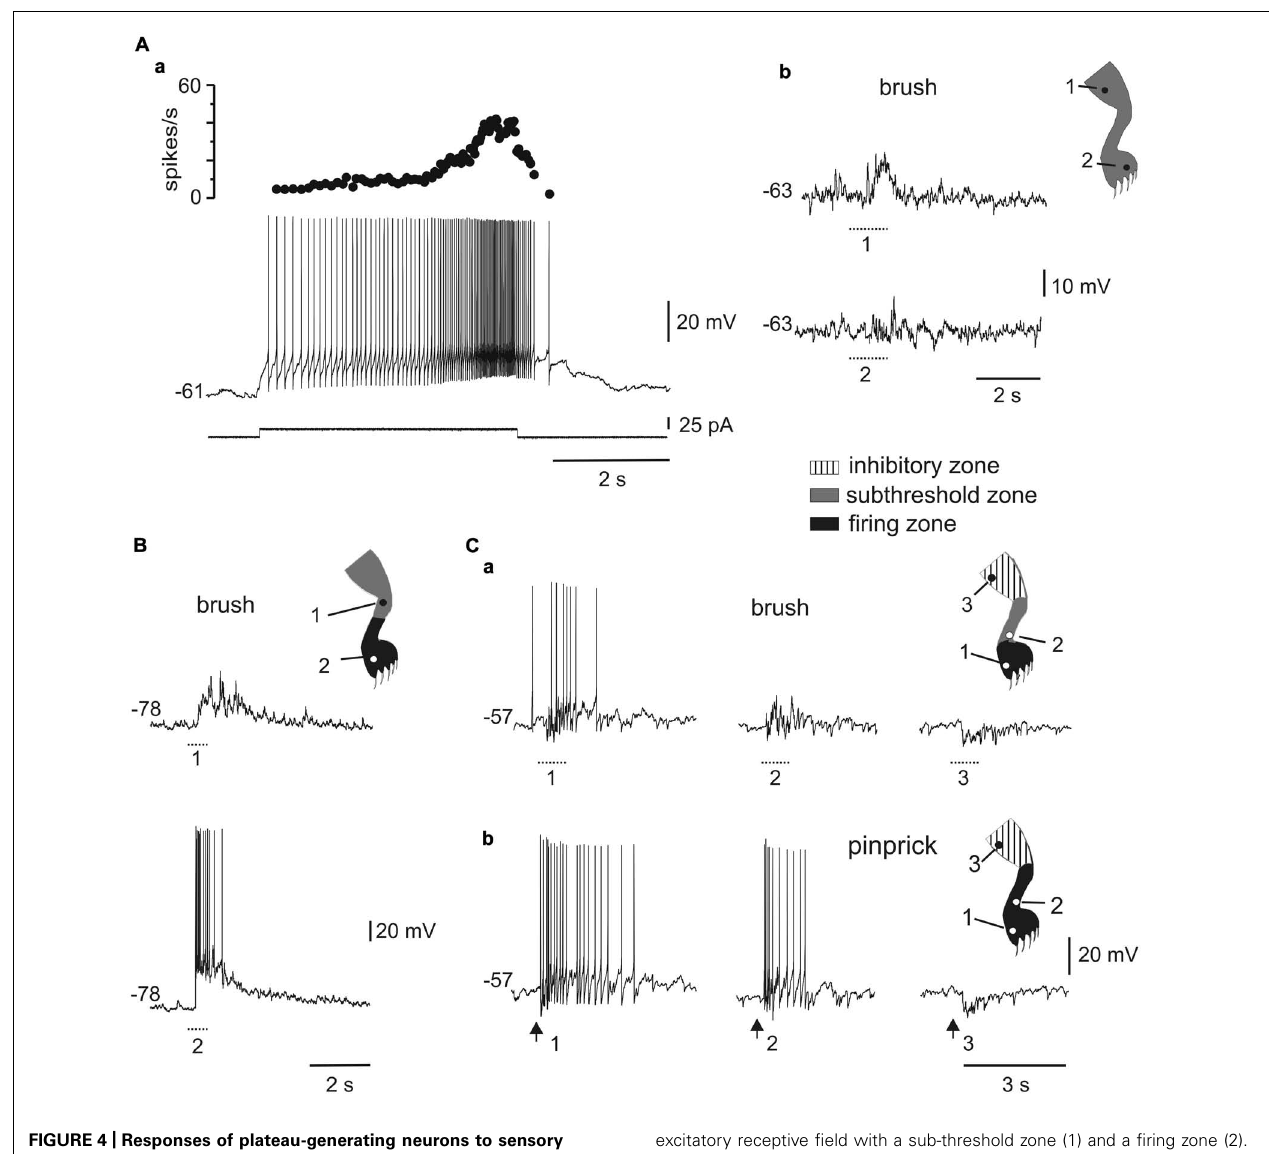
FIGURE 4 | Responses of plateau-generating neurons to sensory stimulation. (A) Incrementing firing frequency and after-discharge generated by a depolarising current pulse (a) . In the same cell, brushing the skin within different zones [ (b) , 1 and 2] of the ipsilateral leg generated sub-threshold synaptic responses. (B) Most plateau neurons had an